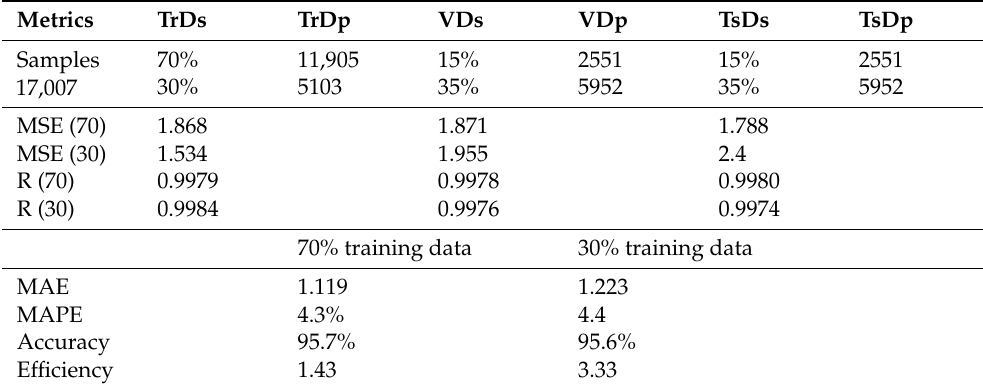
Figure 6. Autocorrelation of error. Table 6. Performance of damped least-squares